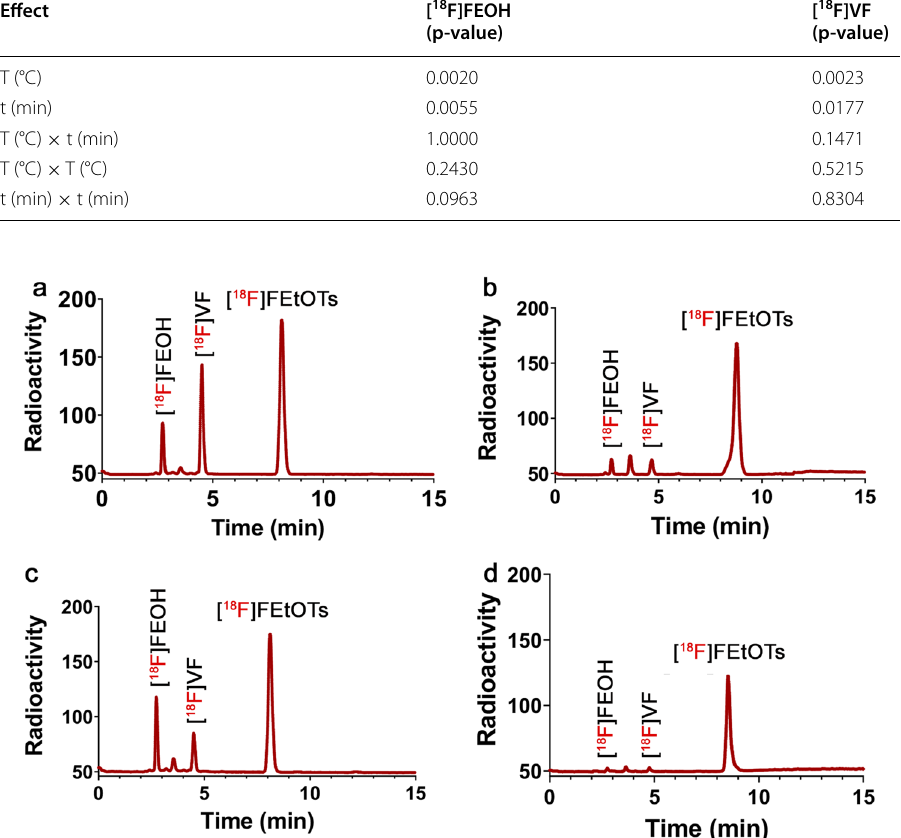
Fig. 4 Radiochromatograms of crude mixtures of [ 18 F]FEtOTs at two different conditions of time, temperature, and molar ratio of base to precursor. a : 130 °C—15 min—0.7. b : 100 °C—1 min—0.7. c : 130 °C—15 min—1.7. d : 100 °C—1 min—1.7. The retention times of [ 18 F]FEOH and [ 18 F]VF were 2.7